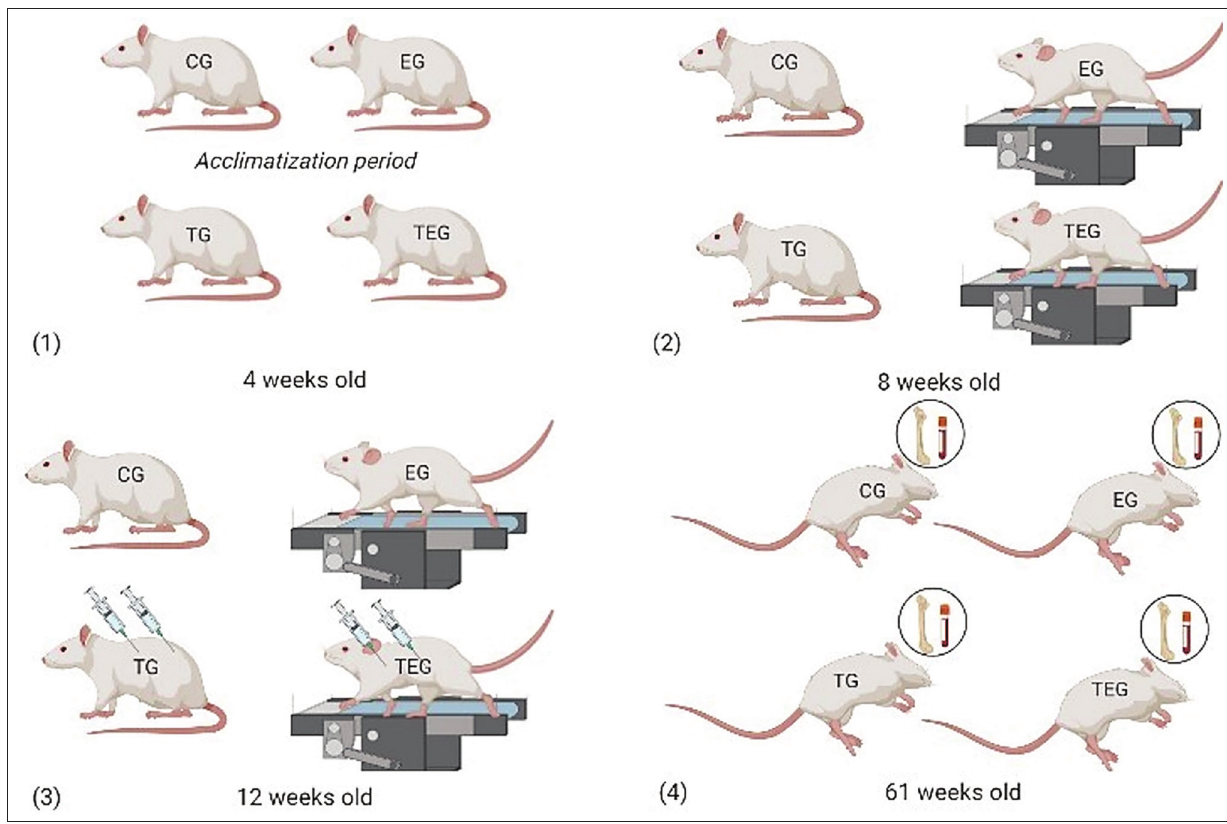
Figure-1: Experimental protocol performed in each one of the four groups: Control group (CG), exercised (EG), testosterone group (TS), and testosterone exercised group (TEG). (1) Quarantine and acclimatization period; (2) initiation of the exercise training; (3) initiation of protocol for testosterone treatment; and (4) animals’ sacrifice and samples’